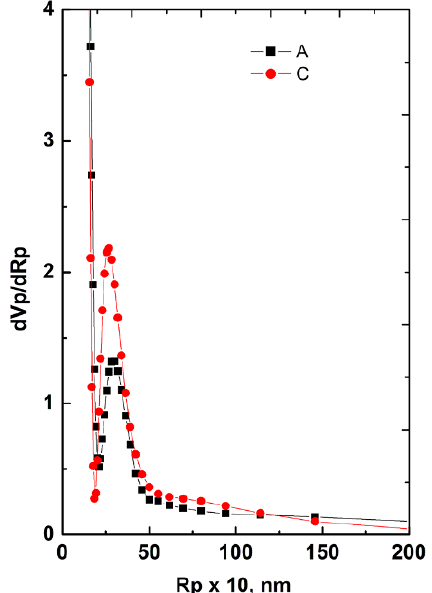
/AC prepared at: 2